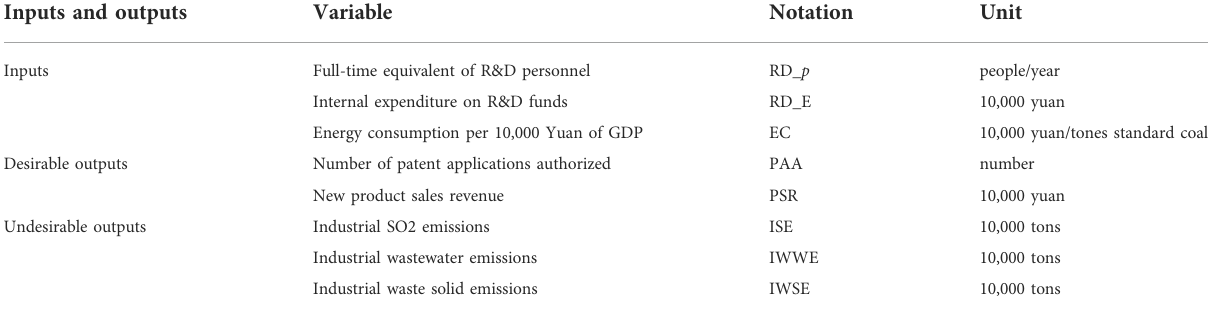
TABLE 2 Regional GIE evaluation indication system.